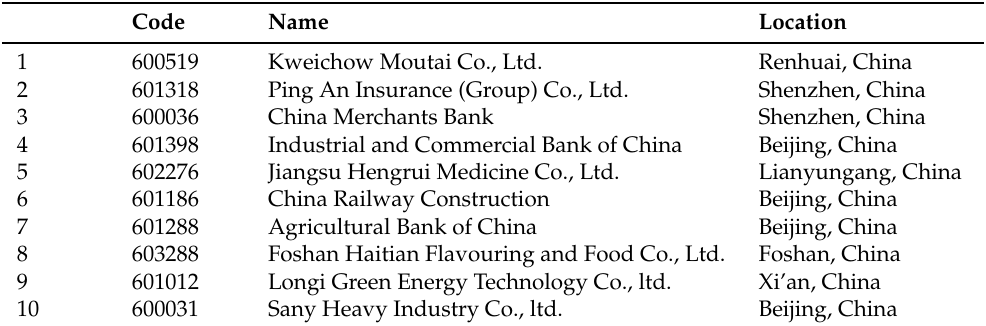
Table 3. Stock list used in the experiments.